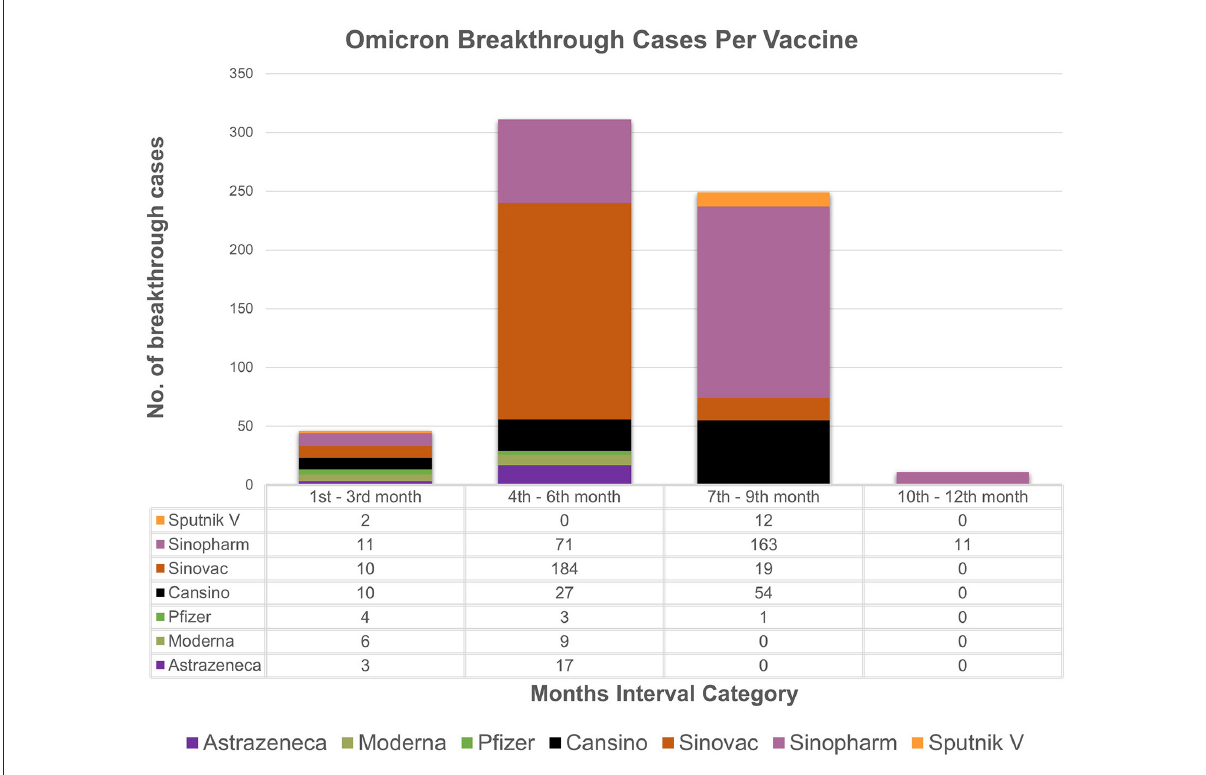
FIGURE1 Breakthrough cases representation: the month’s interval between being fully vaccinated and testing positive for omicron with respect to vaccines. X-axis represents month’s interval while y-axis represents counts of breakthrough